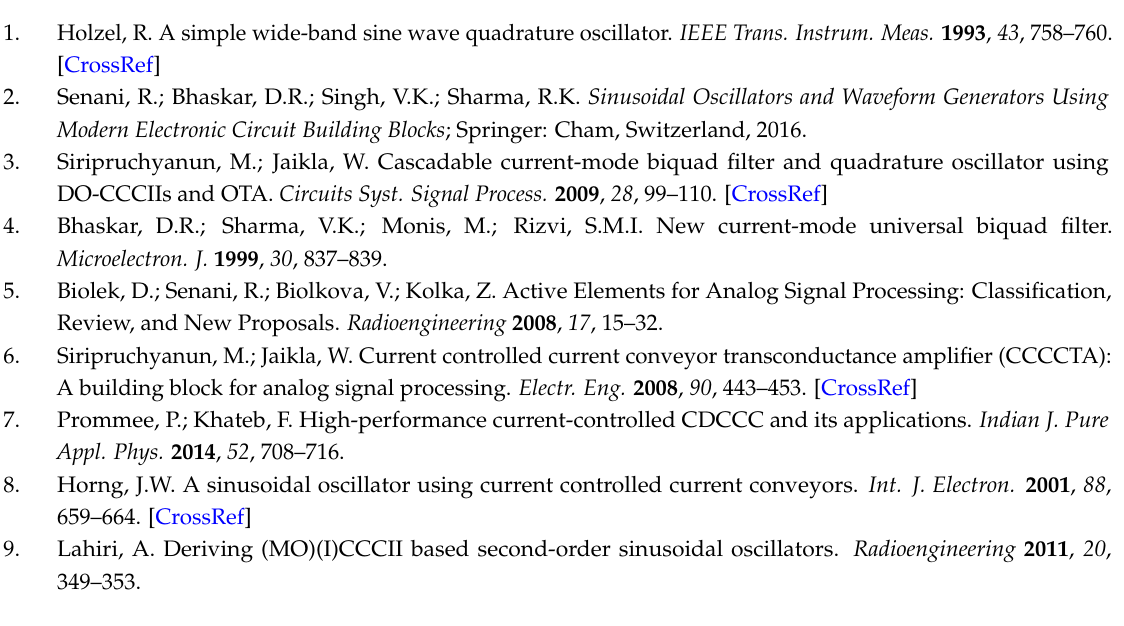
Figure 22. The measured RMS jitter of the proposed oscillator at an operating frequency of 295.2 kHz.